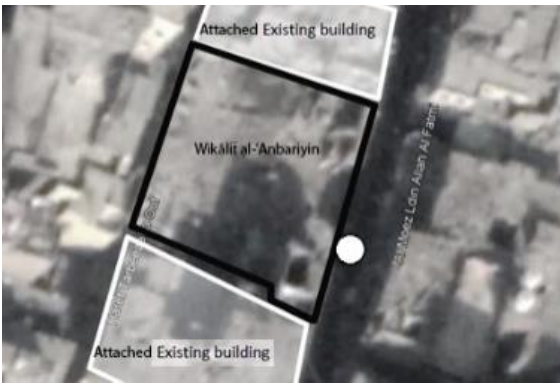
Location of the image: ạl-Mu’iz